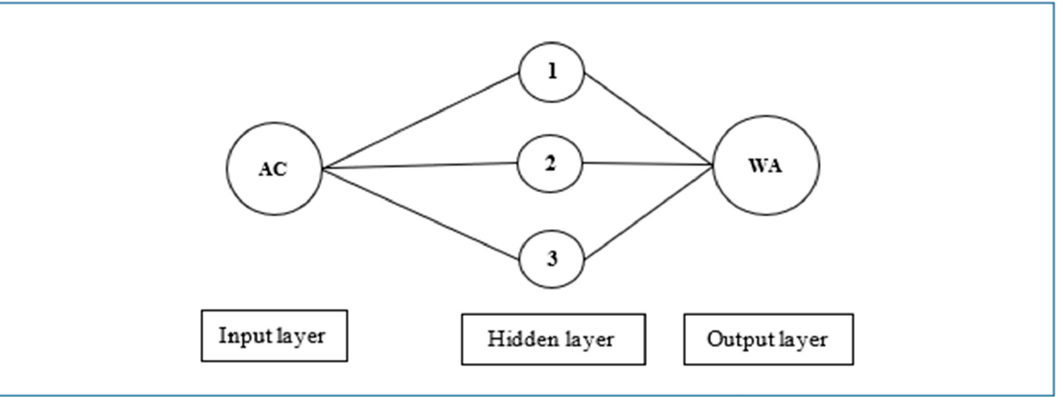
Figure 4. Artificial neuron network architecture for Abrasion Coefficient-water absorption of recy- cled